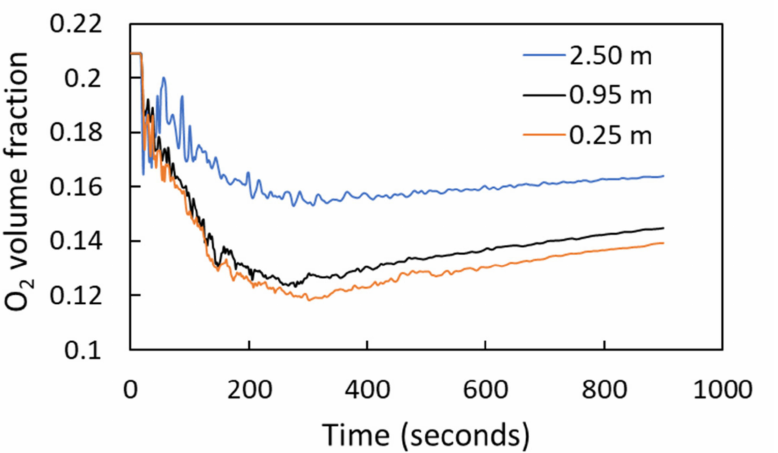
Figure 5. Oxygen volume fraction at 2.5 m, 0.95 m, and 0.25 m above the floor at the corner between the main room and the bathroom.